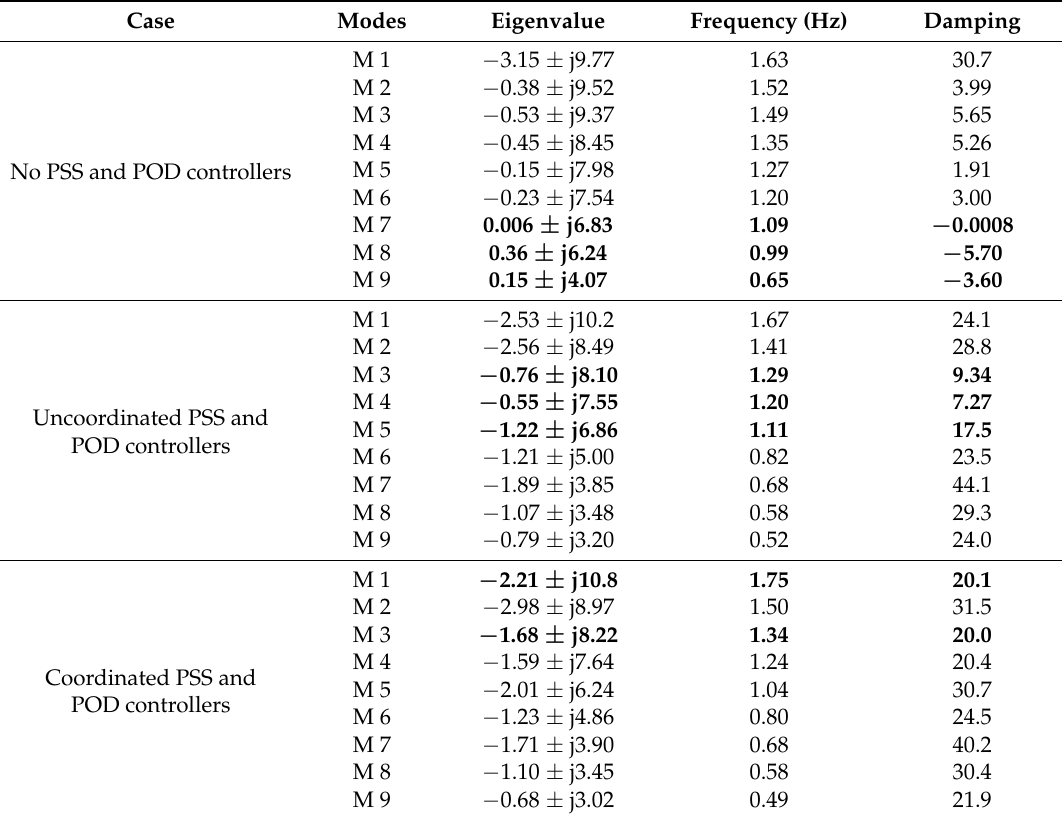
Table 7. The oscillation modes without and with damping